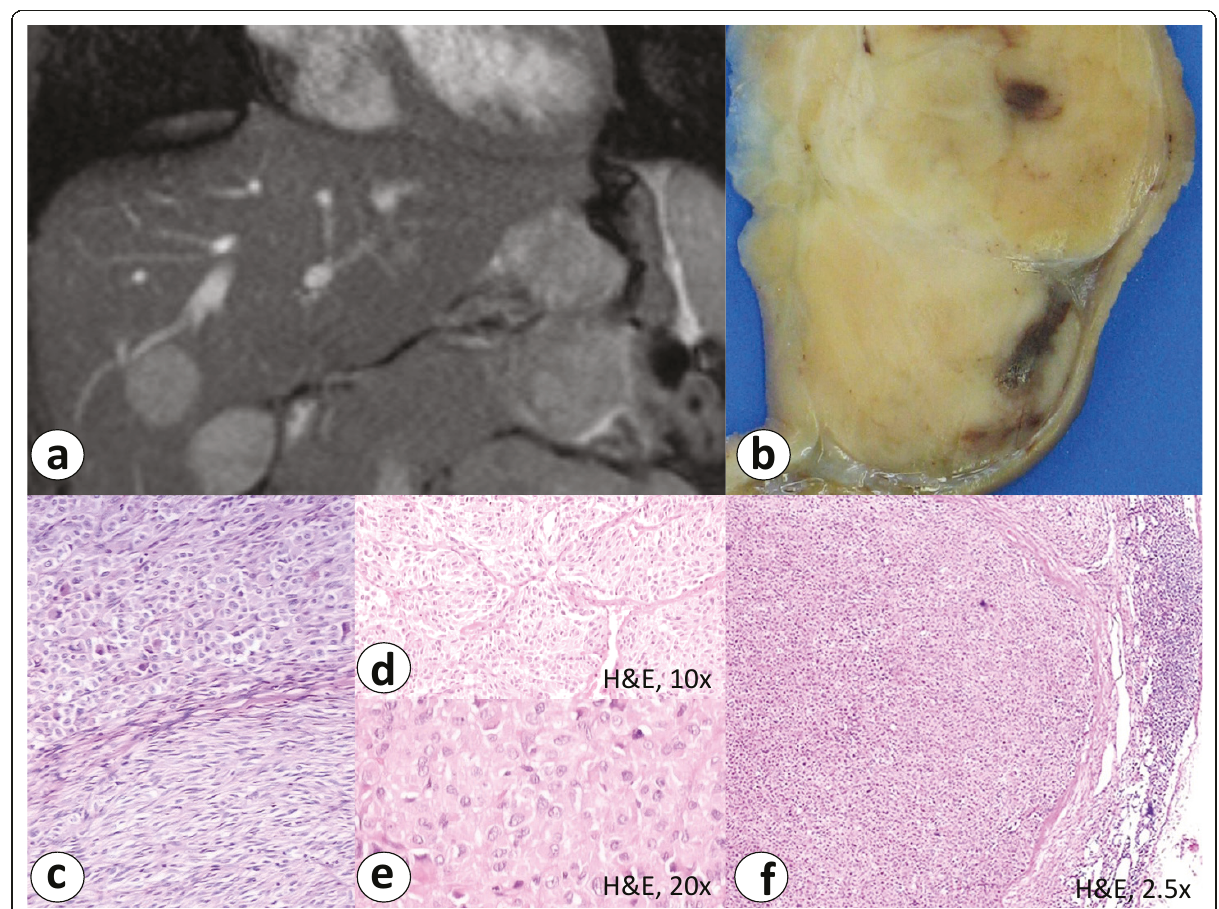
Figure 2 Magnetic resonance tomography in case 2 showed an exophytic, lobulated and ulcerated antral mass diagnosed as gastric GIST with multiple smaller satellite tumor nodules, liver (a, b) and lymph node metastases (f) (H&E staining) . Histology reveals biphasic histomorphological growth pattern (c) with fibromuscular septa (d) and hypercellularity (e) (H&E